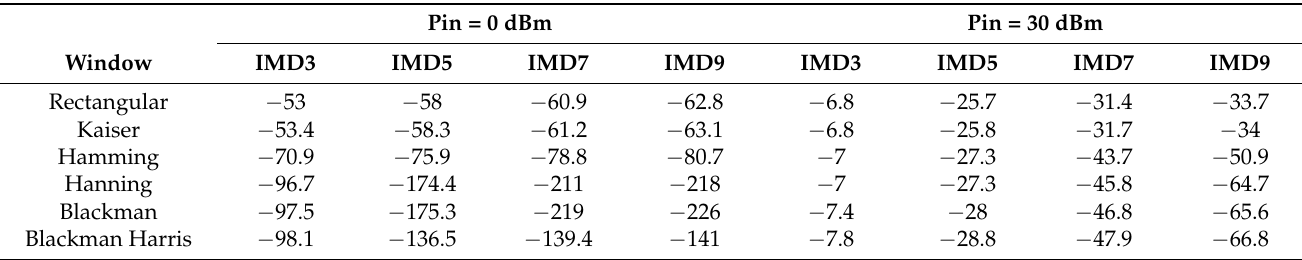
Table 4. IMD estimation using various window